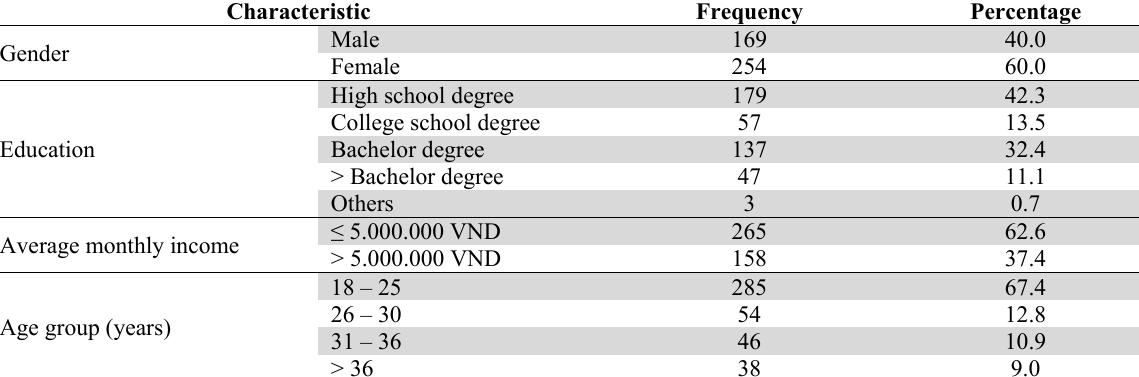
Demographics of the sample (n = 423)